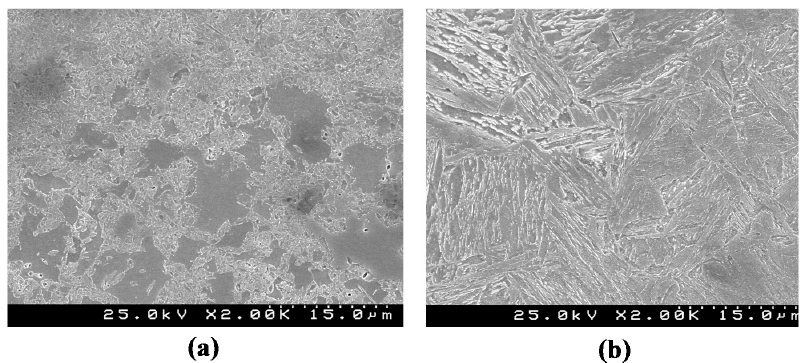
Figure 18. SEM micrographs showing the microstructure change of laser welded DP1000 steel butt joints: ( a ) HAZ; ( b ) FZ.